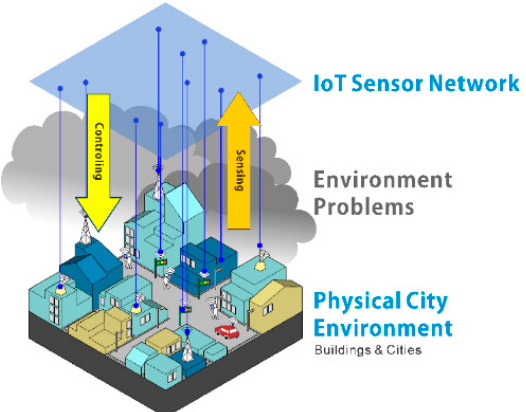
Figure 1. The information gap between the sensor network and citizen feelings. The IoT sensor network only senses the information type and where it is. The gap will appear in locations without sensors.